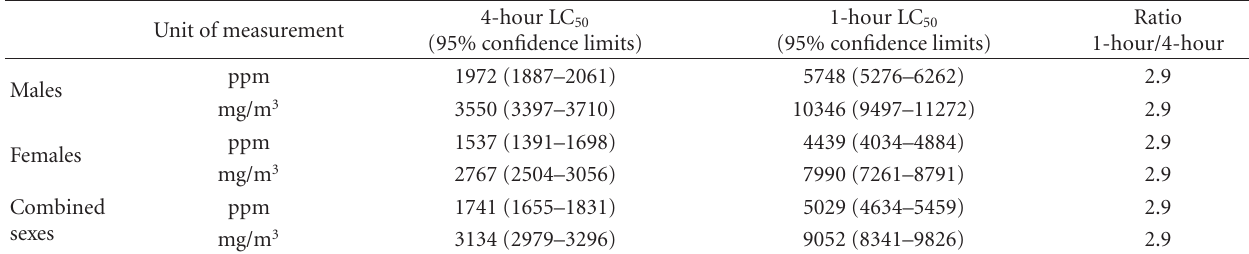
Table 6: LC 50 calculations reported in ppm by volume and converted to mg/m 3